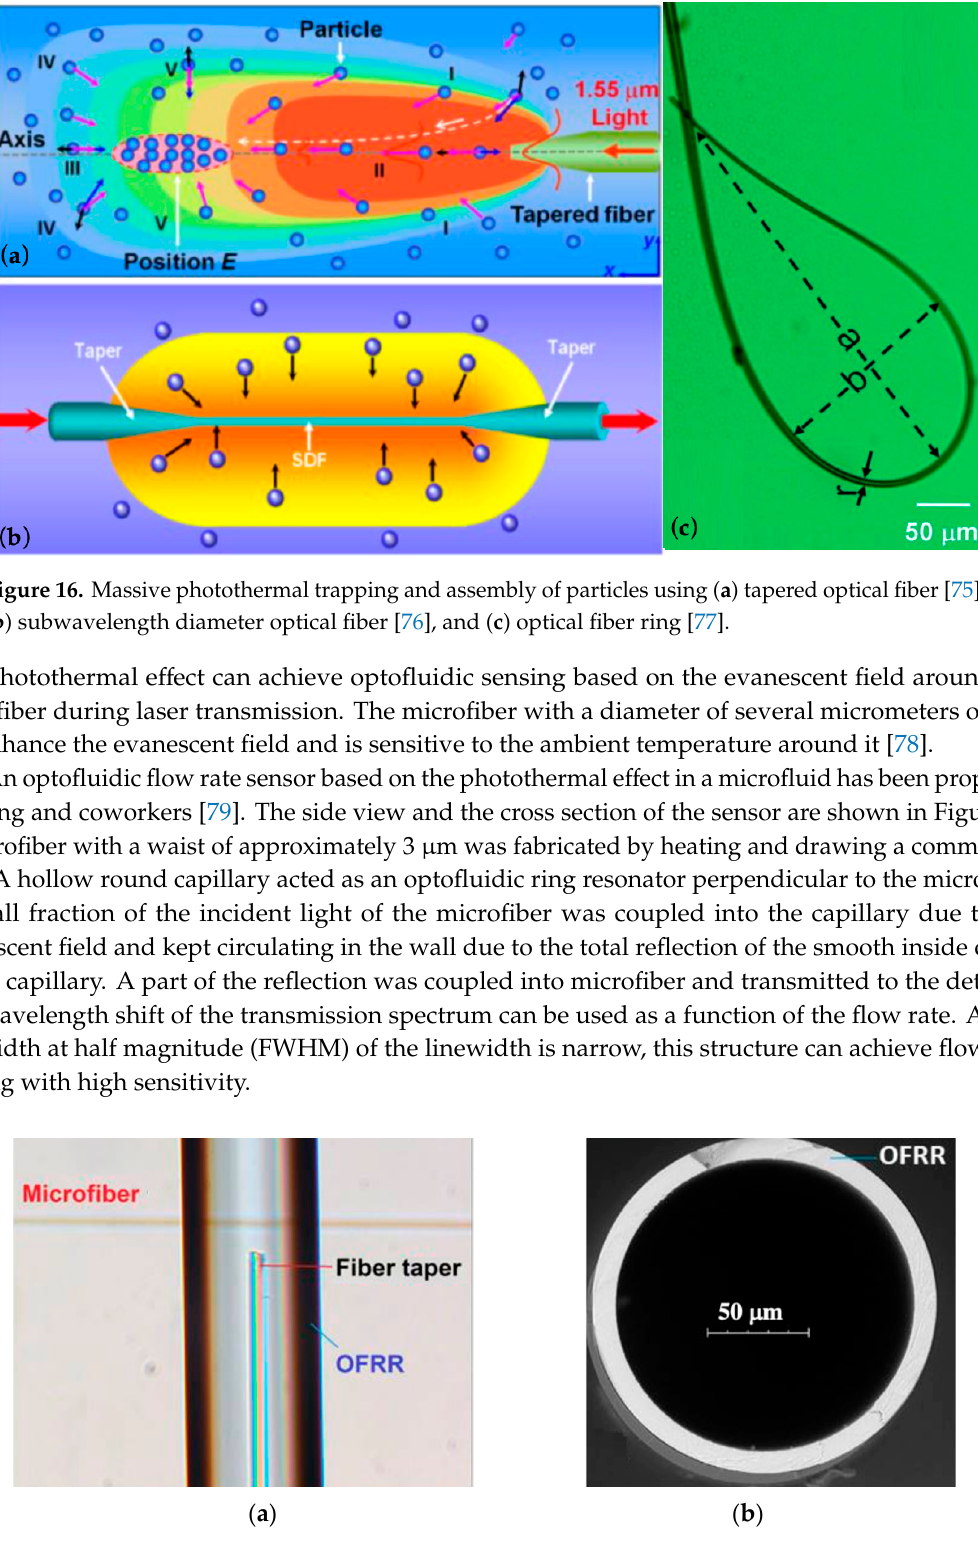
Figure 17. ( a ) The side view and ( b ) the cross section of the sensor of the optofluidic ring resonator [79].